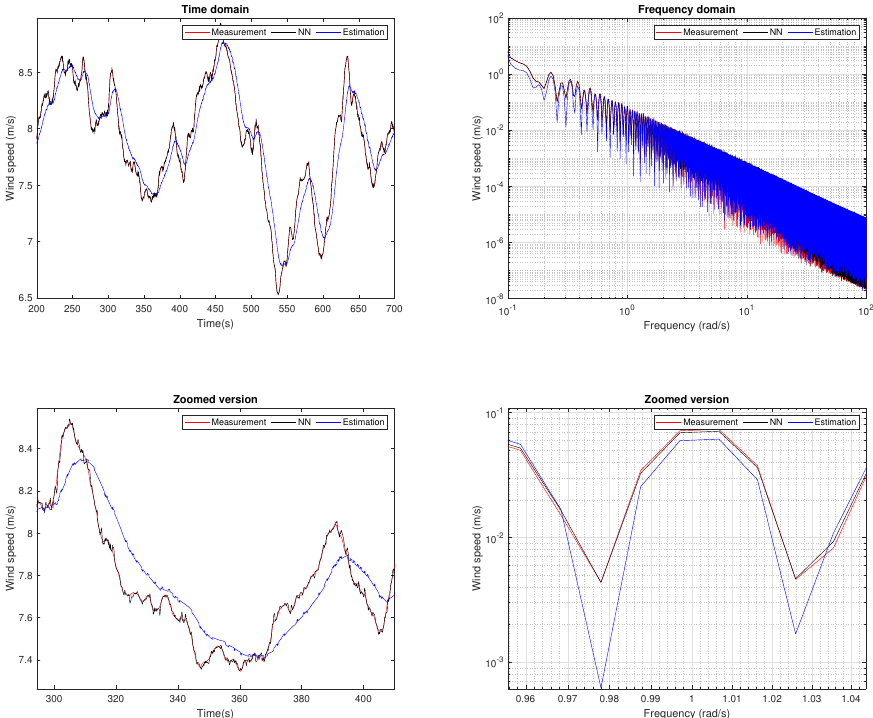
Figure 14. Scenario 5: Wind speed estimation from Turbine